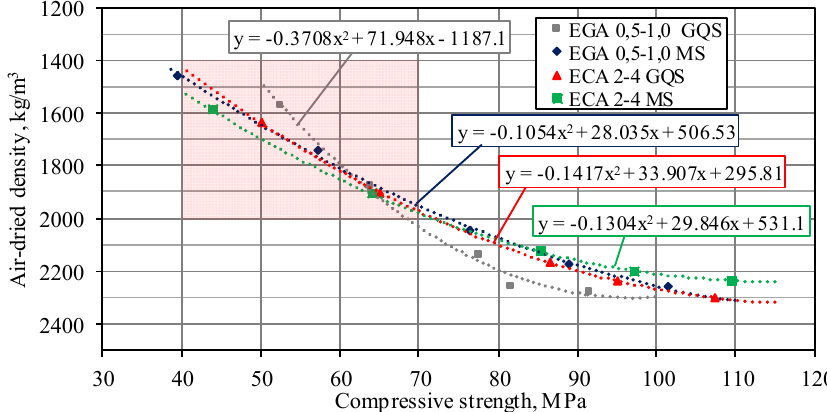
Figure 2. The compressive strength dependence on density for LWAC with EGA or ECA and different microfillers.